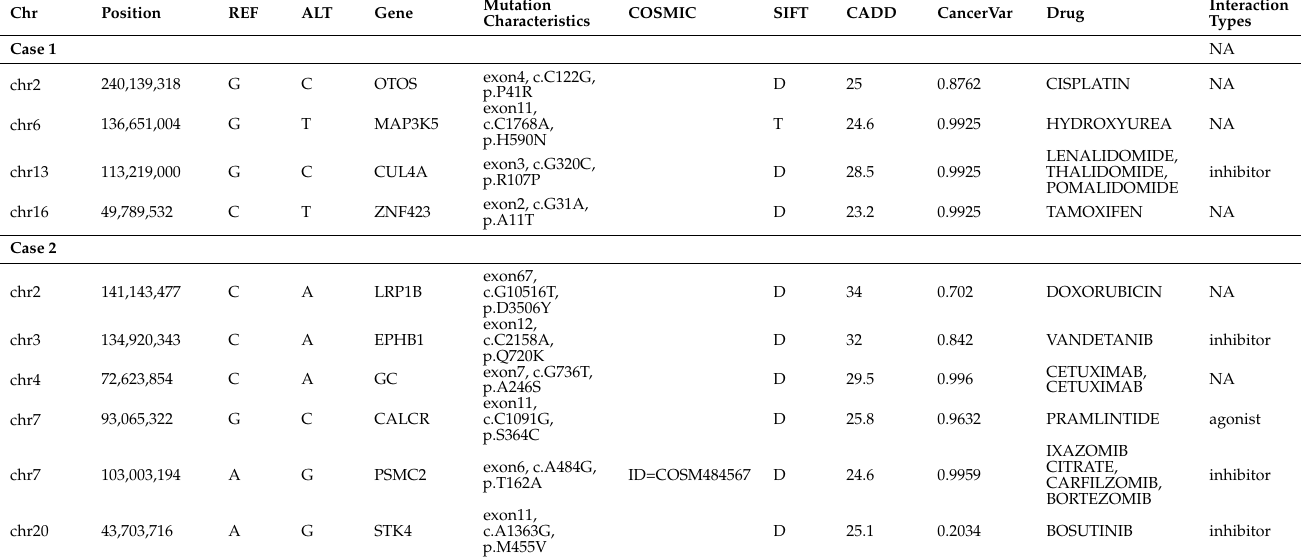
Figure 1. MRI axial 3D T1 gadolinium (Axial view of 3D T1-weighted gadolinium-enhanced MRI) ( A ) and coronal FLAIR ( B ): left temporal lobe intraparenchymal metastatic solid NB lesion, with inhomogeneous contrast enhancement, edema, mass effect, and midline shift. Table 1. Candidate actionable